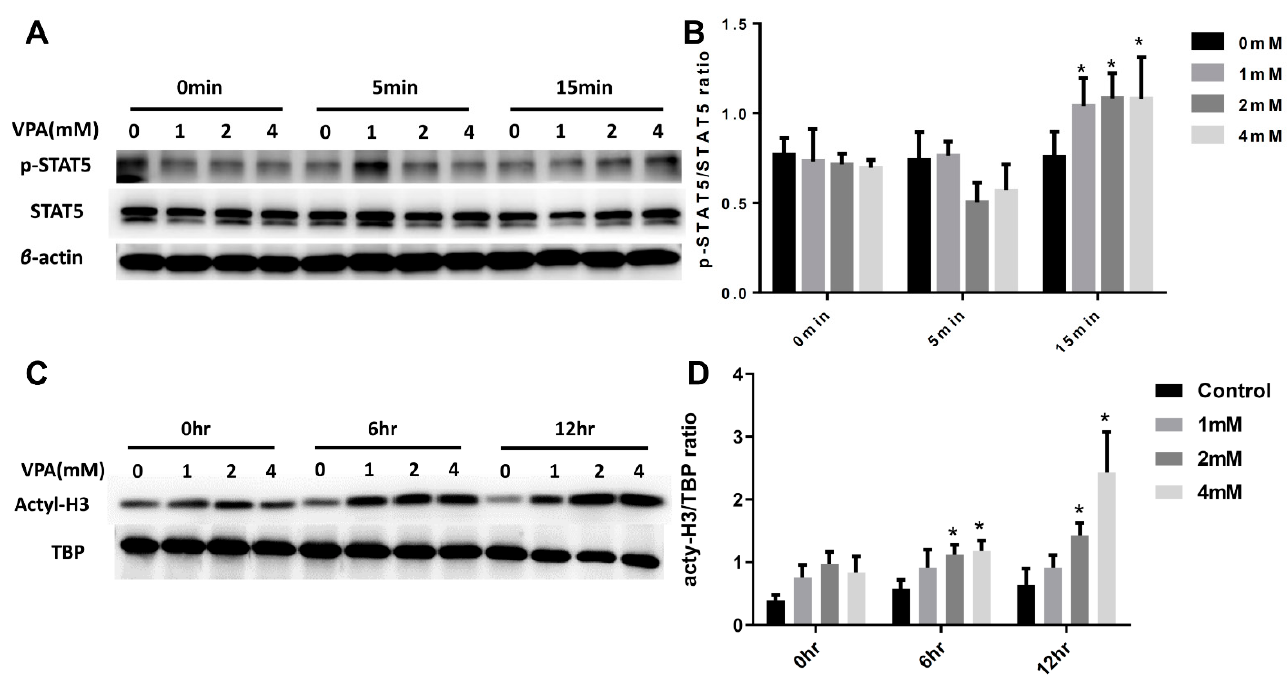
Figure 9. The molecular mechanism of VPA treatment in the induction of Treg cells’ differentiation from naïve CD4 T cells of NOD mouse. The CD4 naive T lymphocytes were cultured with various concentrations of VPA solutions (0 mM, 1 mM, 2 mM, and 4 mM) at different incubation times. ( A ) The levels of STAT5 and ( B ) phosphorylated STAT5 (p-STAT5) were measured by Western blot. ( C , D ) The levels of histone acetylation (acetyl-H3) were assessed by Western blot. Data are expressed as the mean ± SEM (* = p <